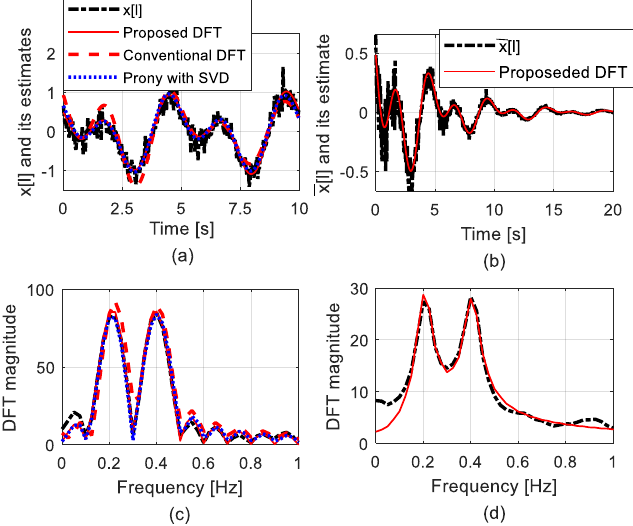
Figure 2. Modal oscillation signal and its estimated signals in the simulation with a 10 dB SNR: ( a ) 𝑥[𝑙] of the first segment and its estimated signals; ( b ) 𝑥 ̅[ 𝑙 ] of the first two combined segments and its estimated signal; ( c ) DFT magnitudes of the signals in (a); ( d ) DFT magnitudes of the signals in (b).